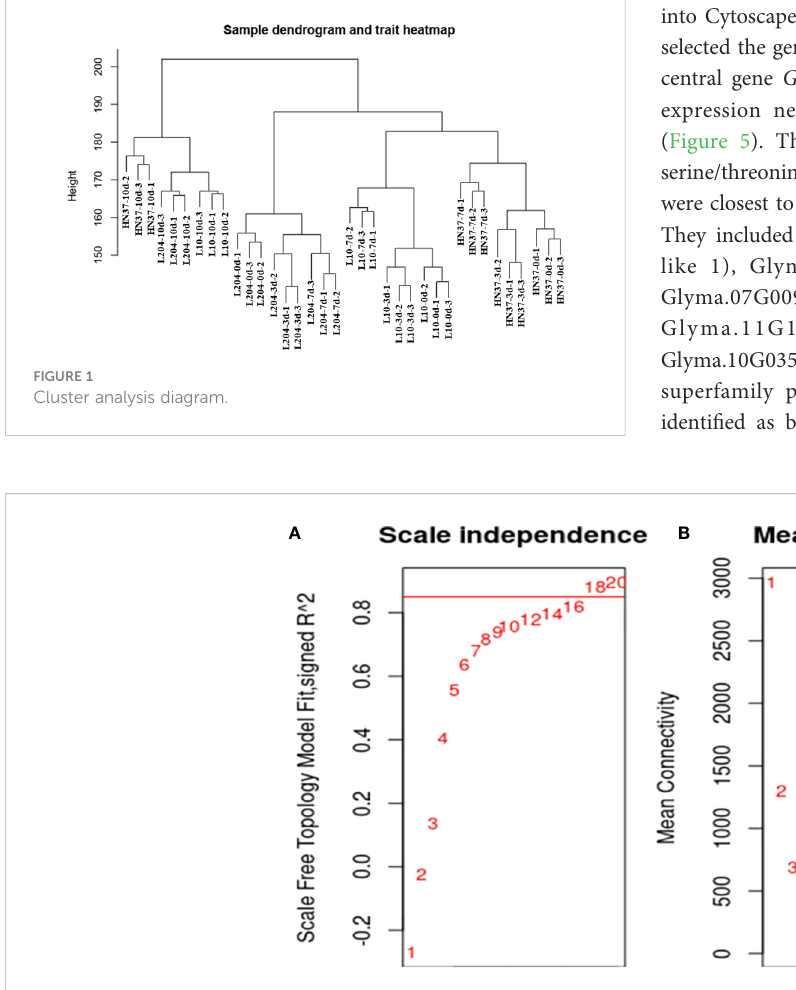
FIGURE 2 Screening of optimal soft threshold. (A) : The soft threshold was determined by the scale-free network index. R2 was set to 0.85, and the best soft threshold was 18; (B) : The soft threshold was determined by network connectivity. The average value of the gene adjacency coef fi cient in the gene network corresponding to different soft thresholds re fl ects the average network connection level. The network connectivity was better when the soft threshold was